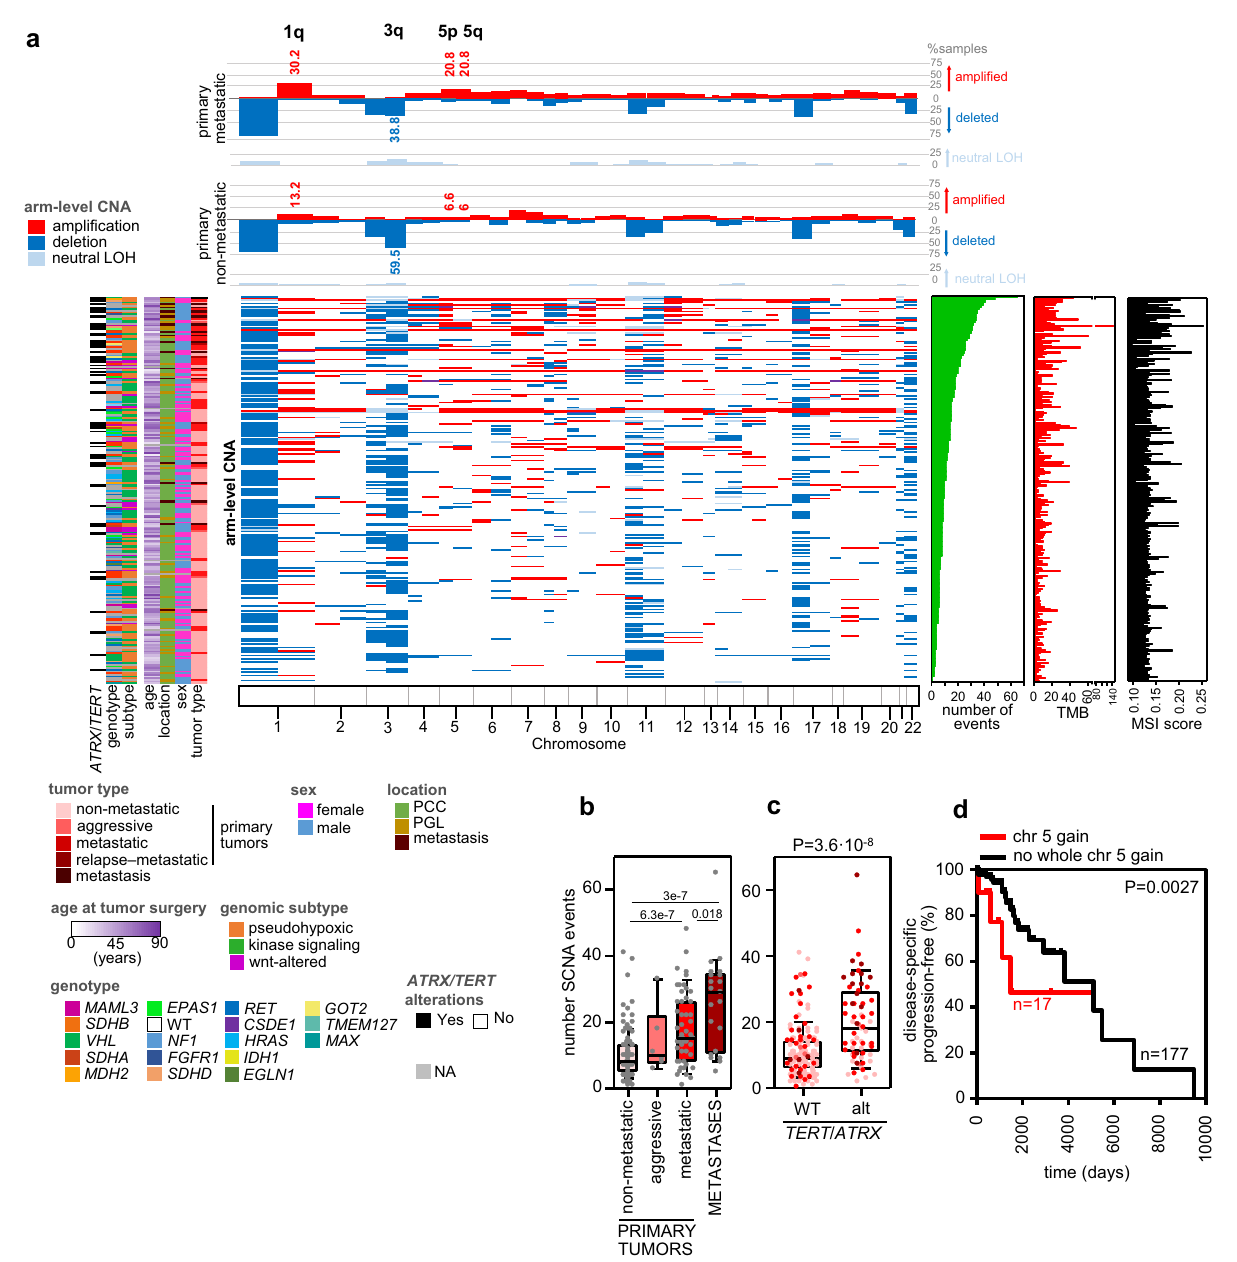
Fig. 3 | Somatic copy number alterations (SCNA) pro fi le in mPPGLs. The data included is from 234 tumor-normal pairs from the CNIO and TCGA cohorts. a Overviewof the arm-levelSCNA, andclinical,molecular and technicalfeatures of the whole series. Tumors have been ranked by SCNA burden (number of SCNA events).Thelegendinthebottomindicatesthecolorcodeforeachitem.Toppanel: %of sampleswitharm-levelCNAinmetastaticandnon-metastaticprimarytumors. Signi fi cant (Fisher test; FDR<0.1) regions between both groups are annotated. b SCNA burden (number of SCNA events) across PPGLs ( n =232). P values shown were calculated with a two-sided MWW test. c SCNA in ATRX / TERT -wild-type (WT) and in ATRX / TERT -altered tumors ( n =232). Two-sided MWW was used to test for